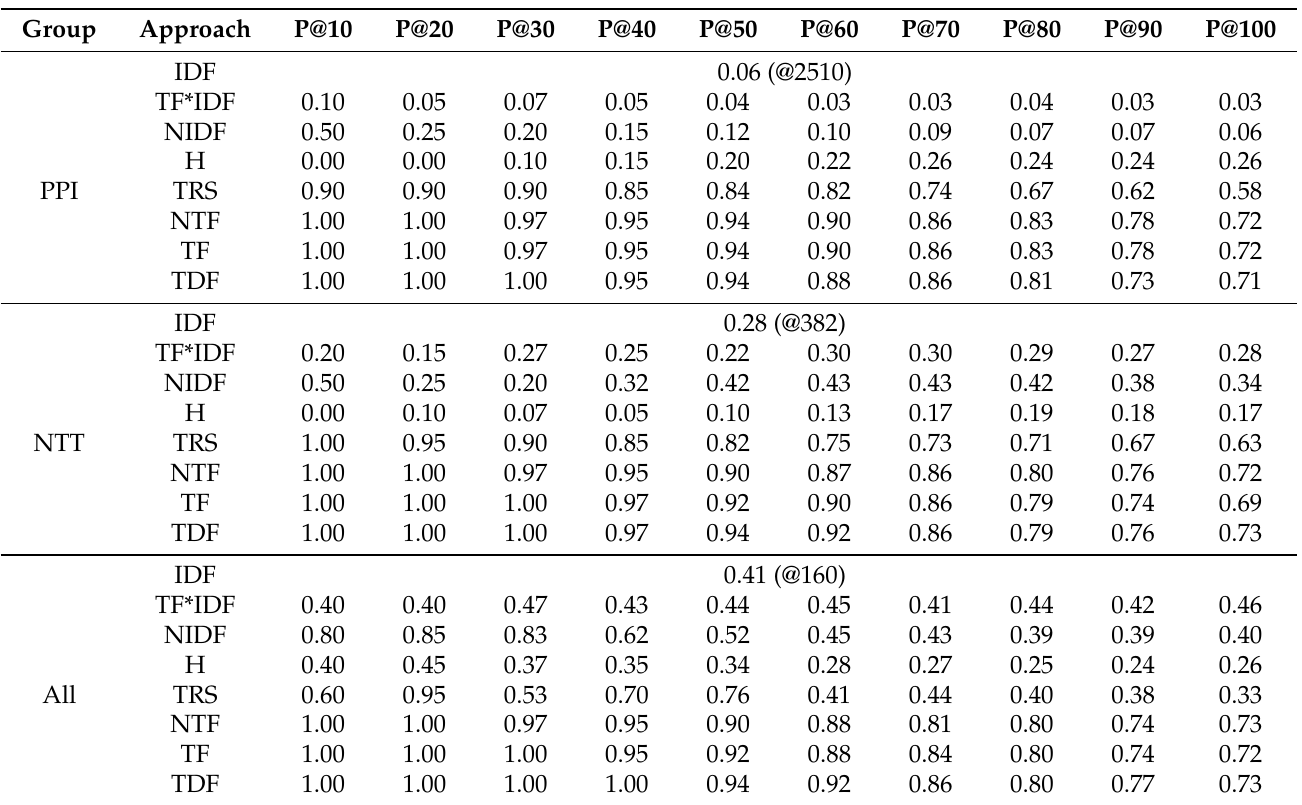
Table 5. Precision of TDF compared to other approaches in the